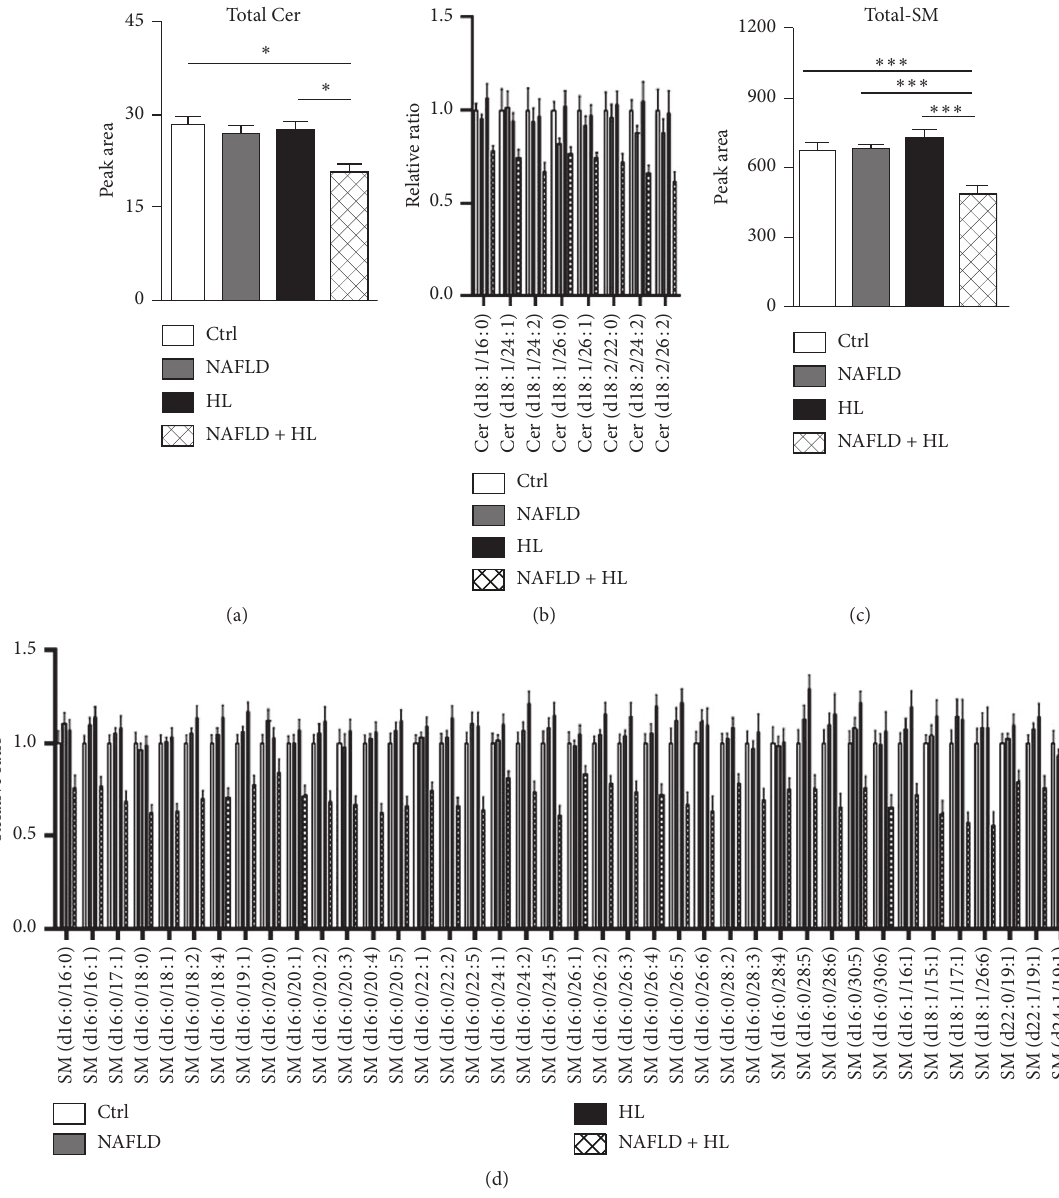
Figure 5: Comparison of the contents of total Cer (a), relative ratio of individual Cer (b), total SM (c), and relative ratio of individual SM (d) in the erythrocyte membrane between four groups. Error bars represent the mean ± SD; ∗ p < 0 . 05, ∗∗ p < 0 . 01, ∗∗∗ p < 0 .